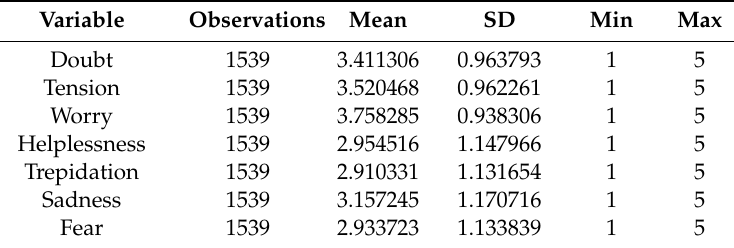
Table 2. Specific descriptions of dimensions of